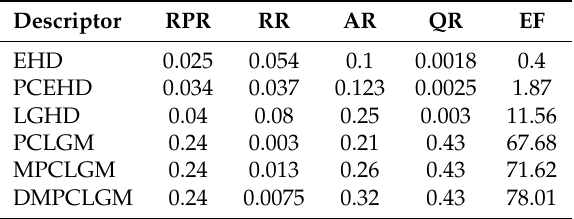
Table 2. Comparison of the six algorithms using the Multimodal Stereo Data set